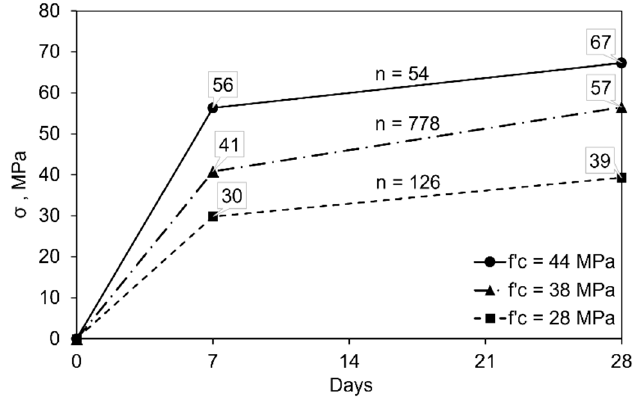
Figure 4. Compressive strength development of the